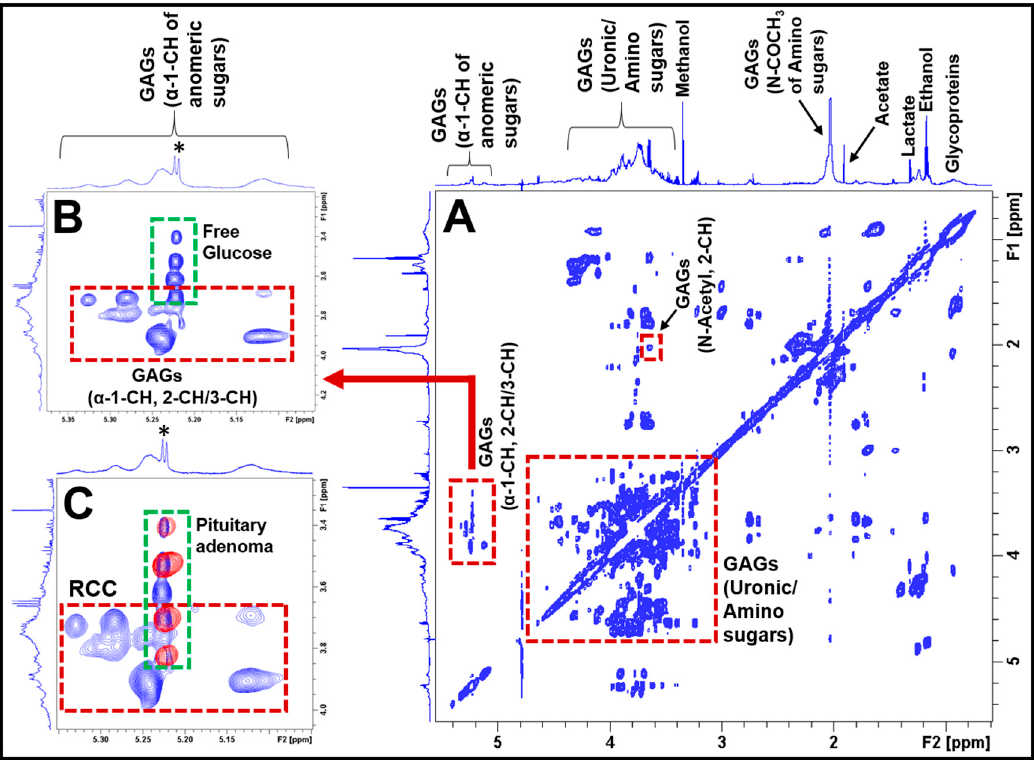
Figure 2 . ( A ) Typical 2D 1 H- 1 H TOCSY spectrum of aqueous extract of an RCC showing 1 H- 1 H spin–spin coupling interactions between different sugar moieties in GAGs. The spectra on the left side and above the 2D TOCSY spectra represent 1D 1 H NMR projections. The inset ( B ) shows the spin–spin coupling interactions between the anomeric α -1-CH and α -2-CH/ α -3-CH protons of the constituent amino and uronic sugar moieties in GAGs (red box). This region also shows the presence of free glucose in RCCs (green box, the asterisk (*) represents 1D 1 H NMR signal of free glucose). The inset ( C ) shows the overlay of anomeric regions of 2D 1 H- 1 H TOCSY spectra of an RCC and a pituitary adenoma. The blue cross peaks are arising from the RCC (red box), whereas the red contours (green box) are from the pituitary adenoma, indicating that the blue cross peaks (in red box) are unique for RCCs.